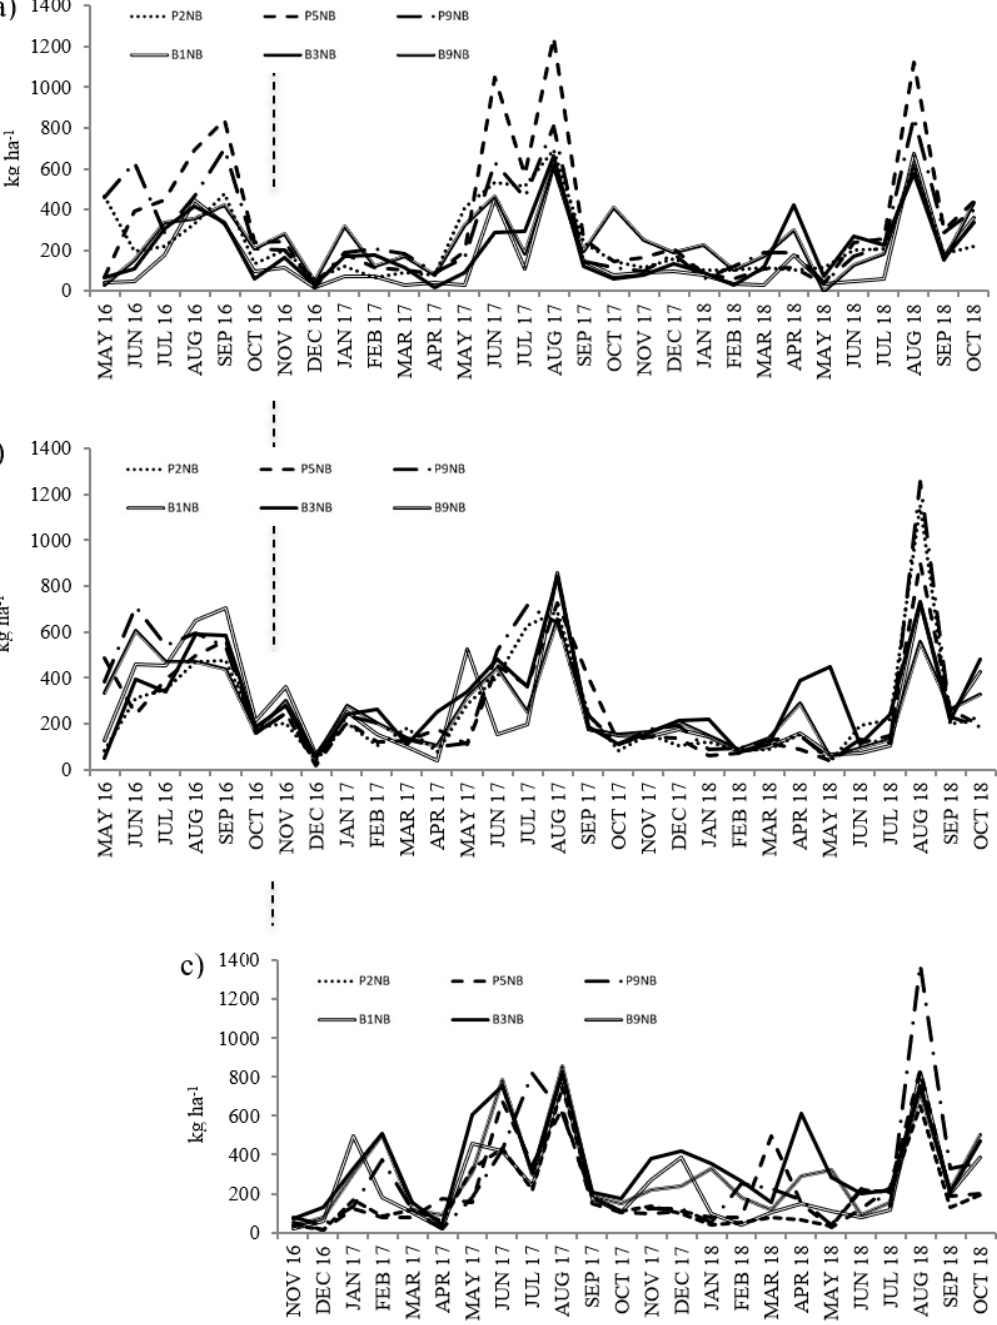
Figure 2. Monthly changes in the amounts of litterfall collected (kg ha − 1 ) in ( a ) unburned plots in the mixed stand (P2NB, P5NB, and P9NB) and the pure stand (B1NB, B3NB, and B9NB); ( b ) plots burned in spring in the mixed stand (P3SB, P4SB, and P6SB) and the pure stand (B2SB, B5SB, and B6SB); and ( c ) plots burned in autumn in the mixed stand (P1AB, P7AB, and P8AB) and the pure stand (B4AB, B7AB, and B8AB).